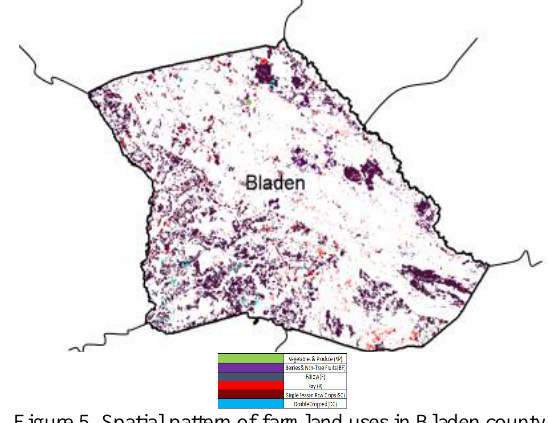
Figure 5. Spatial pattern of farmland uses in Bladen county, 2019.